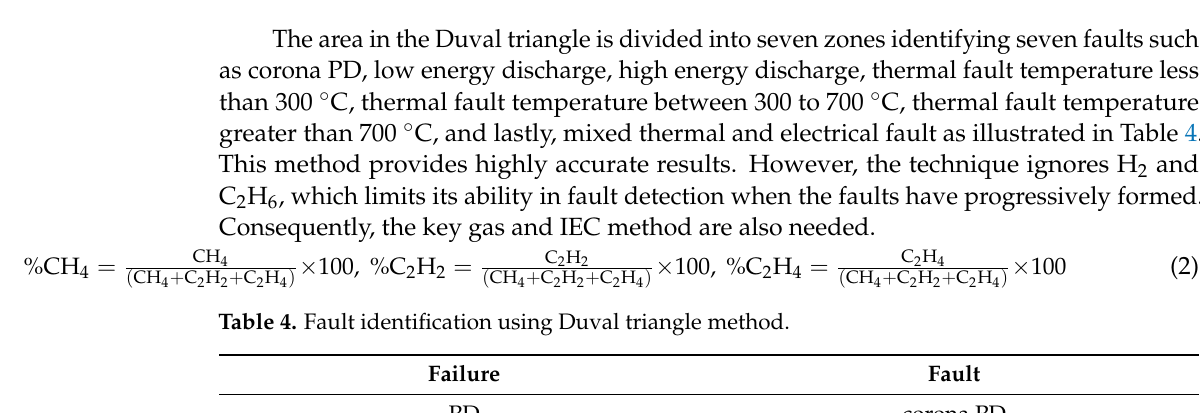
Figure 1. Conventional Duval Triangle.